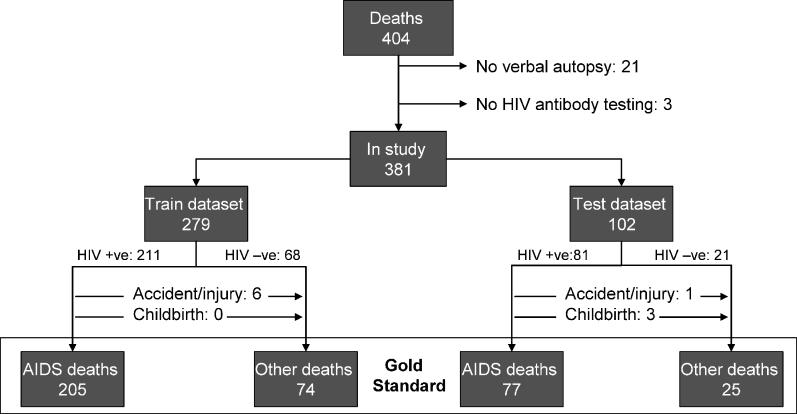
Derivation of Gold Standard from HIV Serostatus at Baseline in the Train and Test Datasets